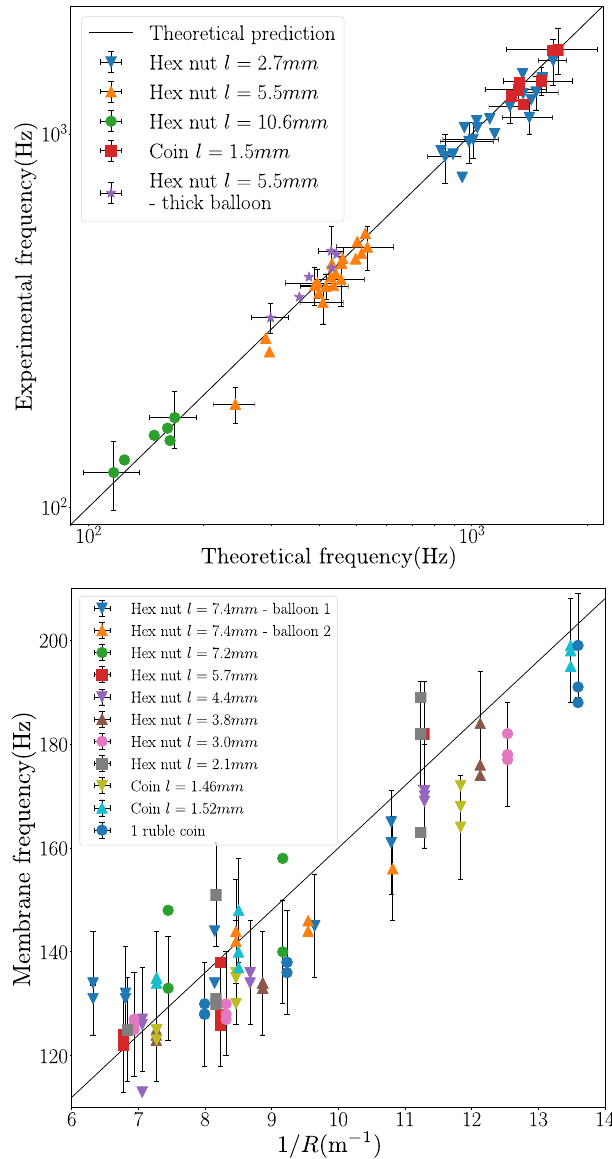
Fig. 7. (Top) Theoretical frequency of the sound plotted against the experimental main sound frequency. A wide range of balloon radius (3–15cm) and different nuts/coins (see legend) were studied. Frequencies ranging from 100 Hz to little less than 2000 Hz were reached. The theoretical prediction is plotted as a black line. (Bottom) Lowest vibrational frequency of the balloon membrane plotted as a function of 1 /R . A wide range of balloon radius (3–15cm) and different nuts/coins (see legend) were studied. Frequencies from 100 Hz to 200 Hz were